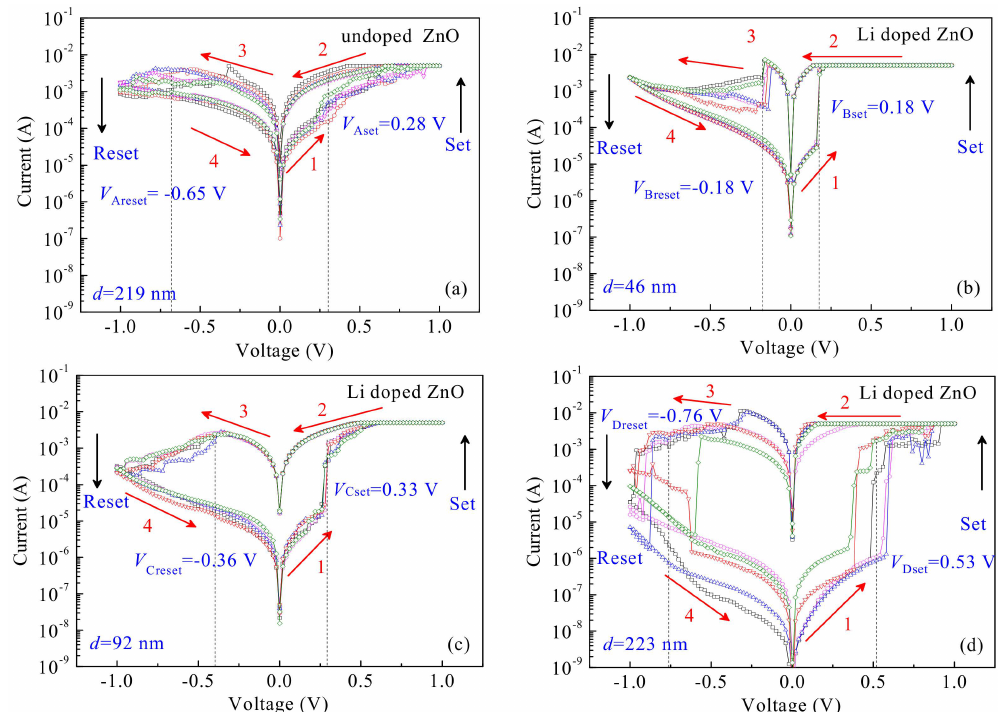
Figure 4. The I - V characteristics of devices at a DC voltage: ( a ) device-A; ( b ) device-B; ( c ) device-C; ( d )